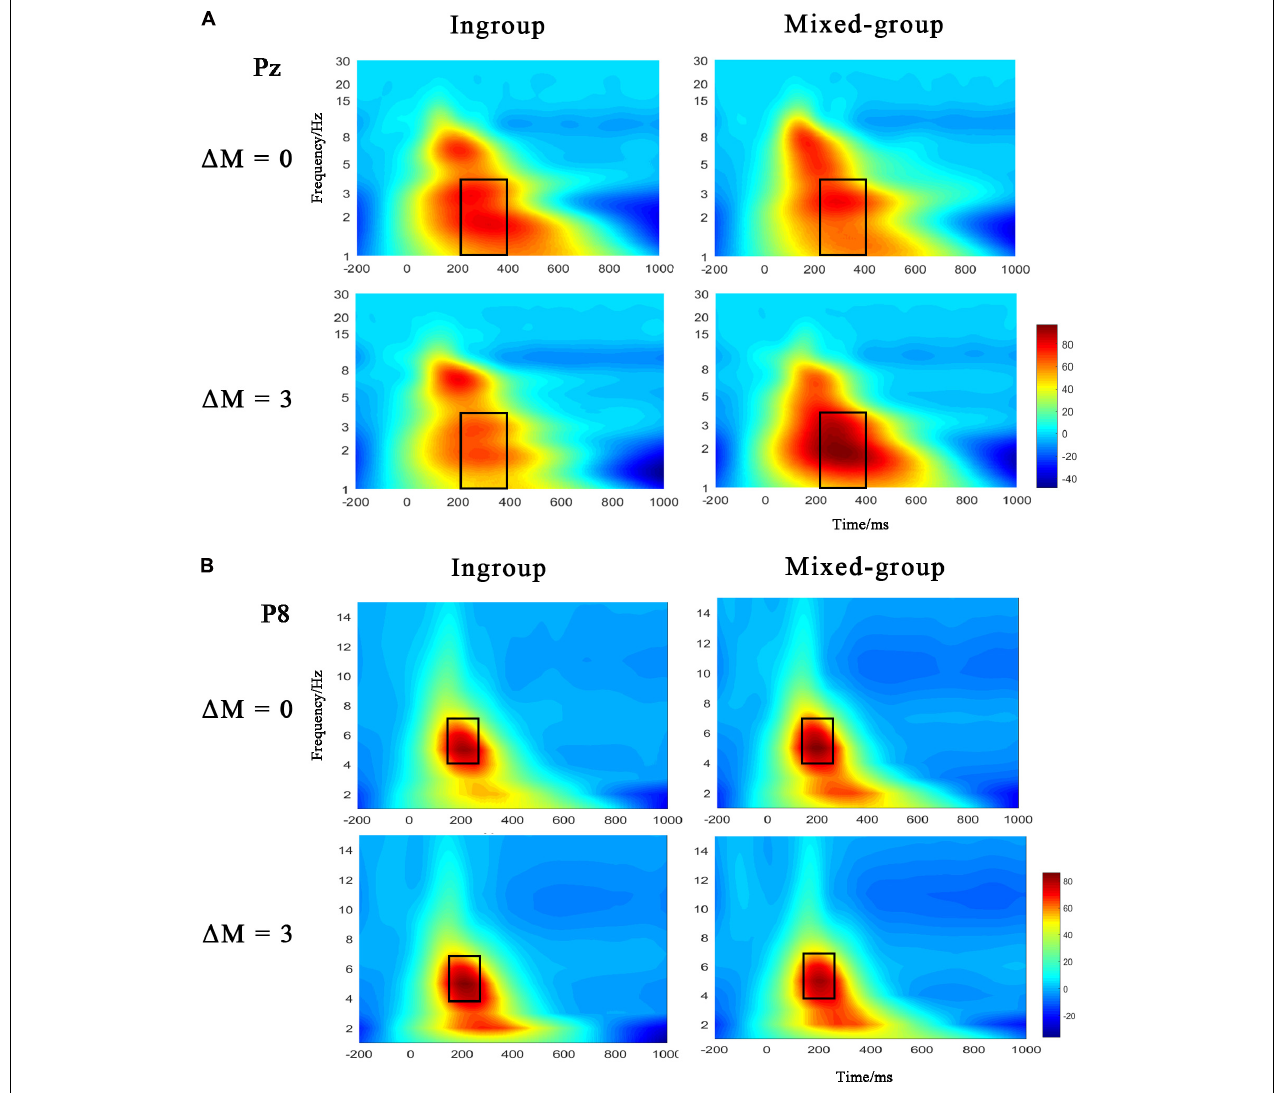
FIGURE 4 | (A) Time-frequency representation of ERP signals at the electrodes Pz for delta activity (1–4 Hz). (B) Time-frequency representation of ERP signals at electrodes P8 for theta activity (4–7 Hz). Dark rectangles marked the time/frequency window used in the statistical analysis.